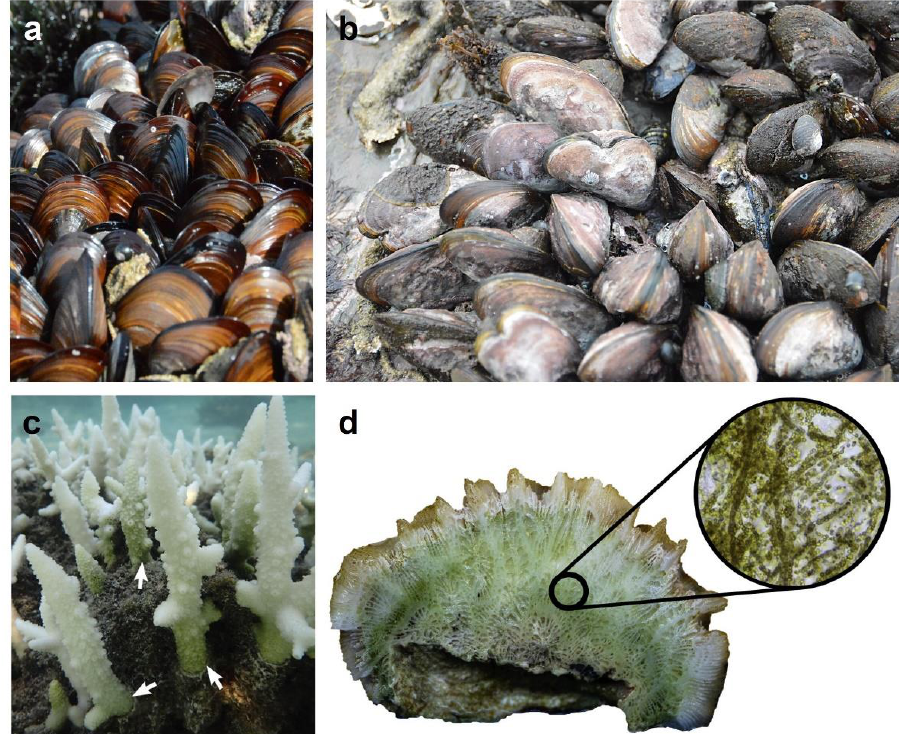
Figure 3. Signs of infestation by euendolithic microborers in live marine calcifiers. ( a ) Non-infested Perna perna bed. ( b ) Perna perna mussels showing extremely eroded shells due to the action of euendolithic cyanobacteria. ( c ) Bleached coral with evident Ostreobium bloom (indicated by white arrows). ( d ) Cross-section of Paragoniastrea australensis coral showing Ostreobium that inhabits the skeleton. The inset shows Ostreobium filaments after skeletal decalcification. Copyright: © Alexia DIEVART ( a , b ), © Alexander Fordyce ( c ). Images ( c , d ) from [74].